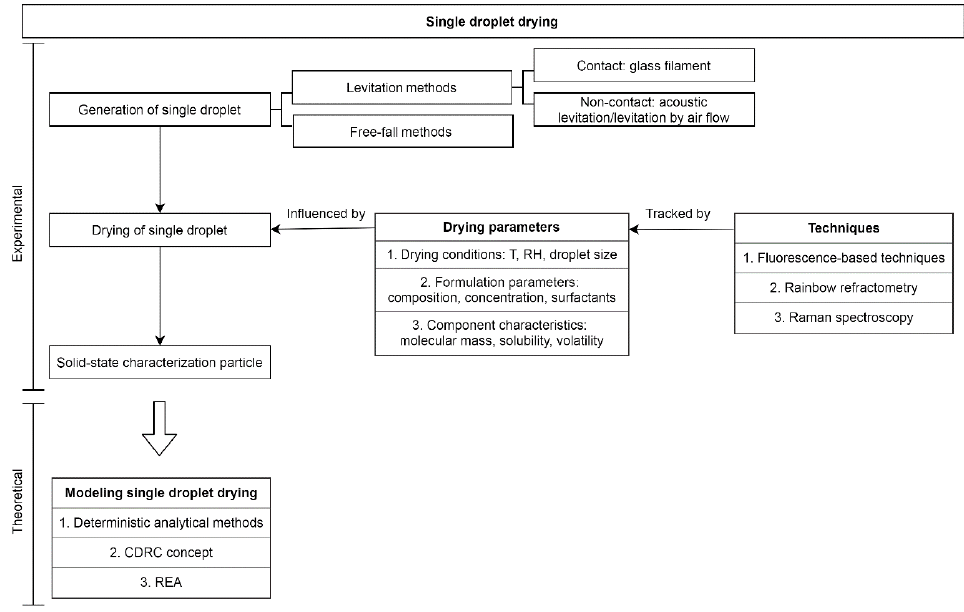
Figure 11. Flow chart single droplet drying process. Pharmaceutics 2020 , 12 , x